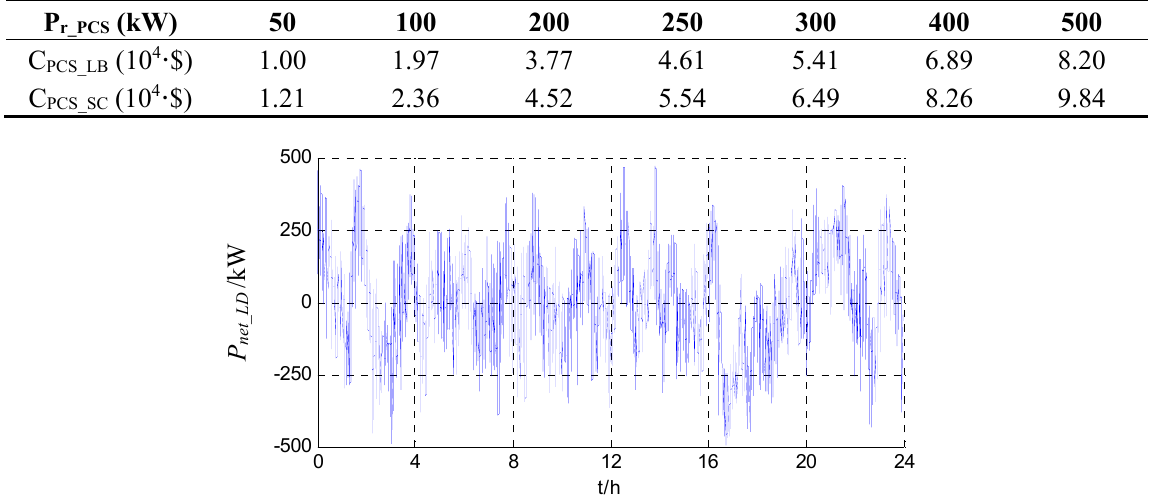
Figure 5. Net load curve of the standalone microgrid in one day.